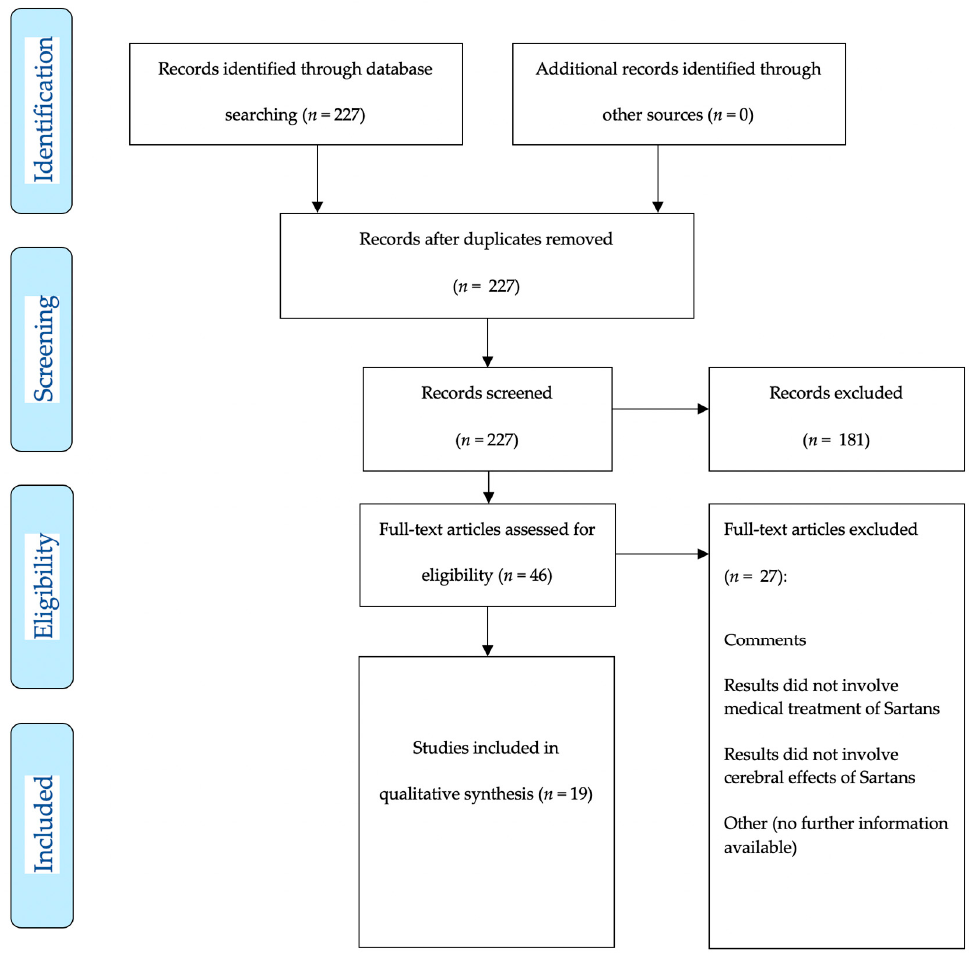
Figure 2. Two hundred and twenty-seven articles (published 01-01-1980–01-07-2019) were